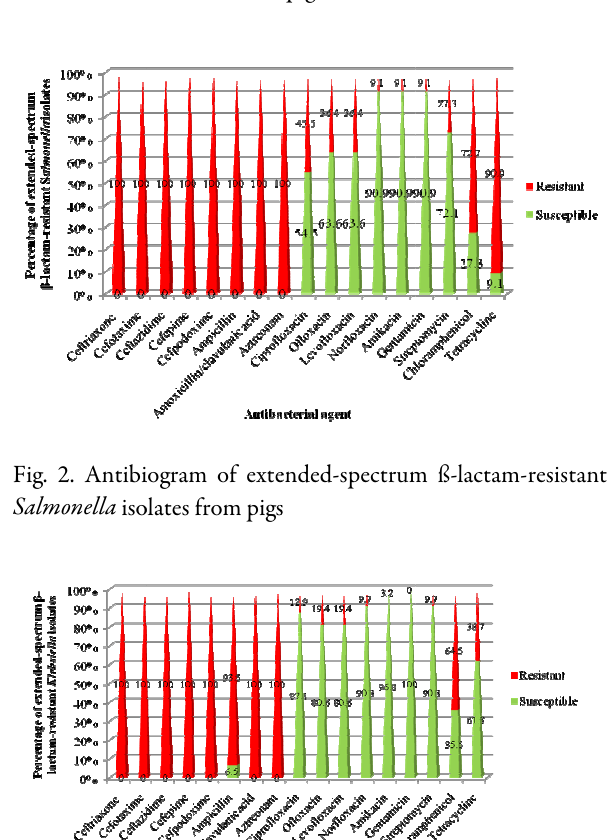
Fig. 1. Prelevance of extended-spectrum ß enterobacterial isolates from pigs